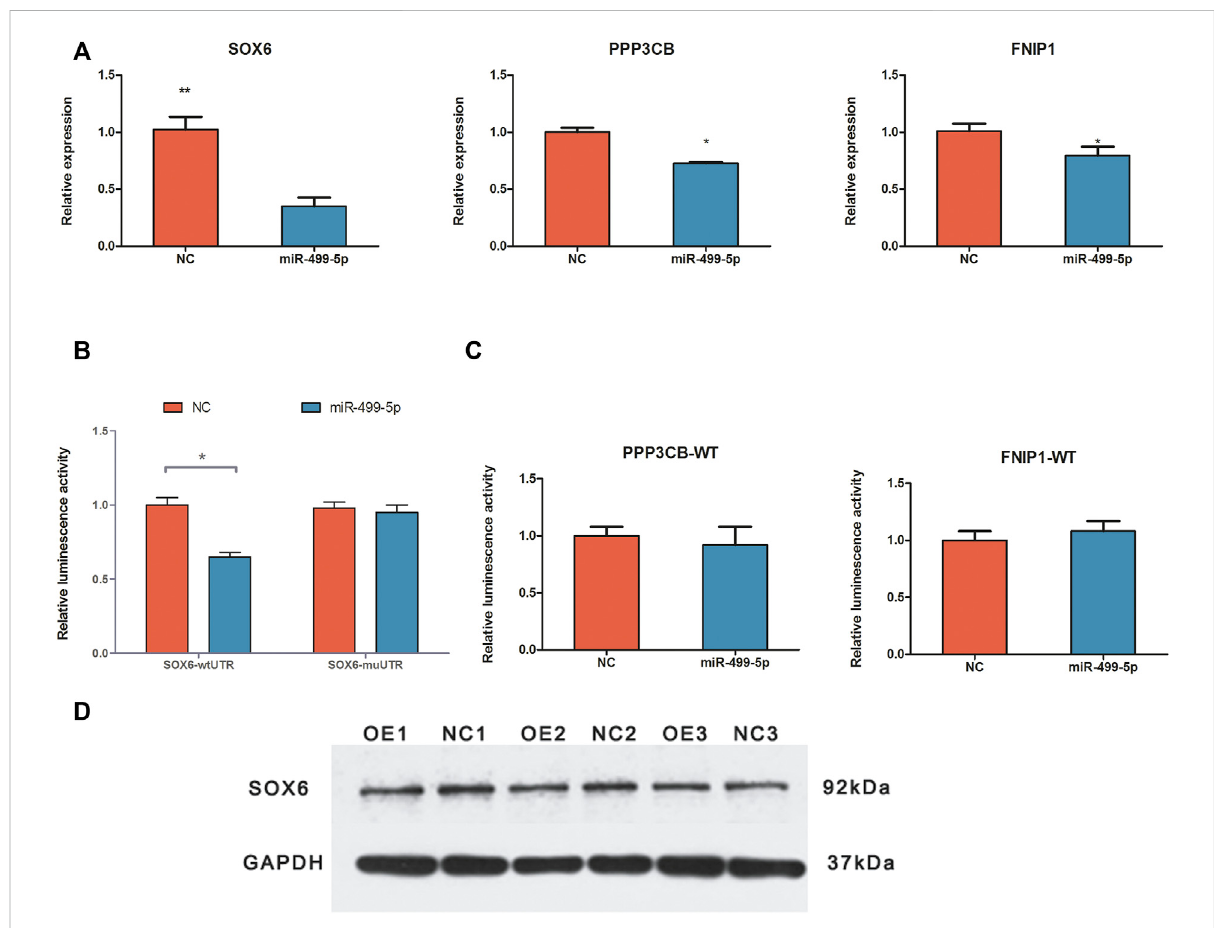
FIGURE 4 Validation of targeted binding relationship between miR-499-5p and target genes. (A) The relative expression levels of SOX6 , PPP3CB , and FNIP1 in miR-499-5p overexpressing CPMs and negative control by qRT-PCR; (B) Results of luciferase reporter assay for SOX6 and miR-499-5p; miR-499-5p binding site mutant and wildtype vector of SOX6 ’ s 3 ’ UTR were used. (C) Results of the luciferase reporter as say for PPP3CB /miR-499- 5p and FNIP1 /miR-499-5p; only wildtype vectors were used. All results are shown as mean ± SD. ** p < 0.01 and * p < 0.05 as compared with control. (D) The protein levels of SOX6 in miR-499-5p overexpressing CPMs and negative control by western